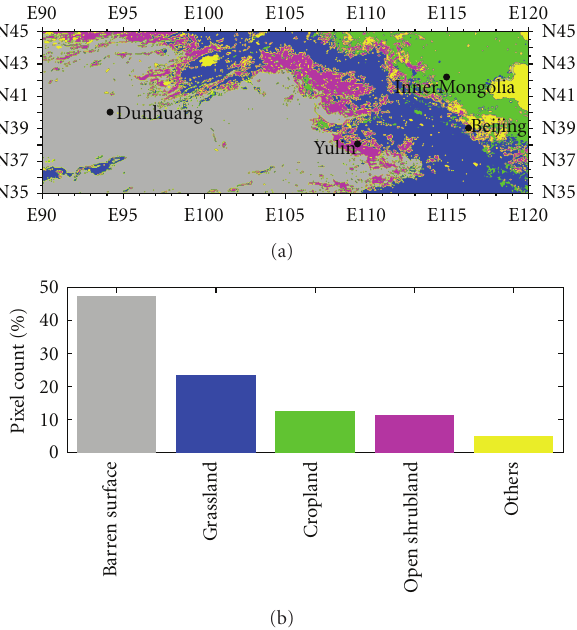
Figure 2: (a) MODIS land cover map of the study domain. The locations of four AERONET sites (Dunhuang, Inner Mongolia, Yulin, and Beijing) are also shown. (b) Dominant ecosystem types identified from MODIS land cover statistics: barren surface, cropland, grassland, and open